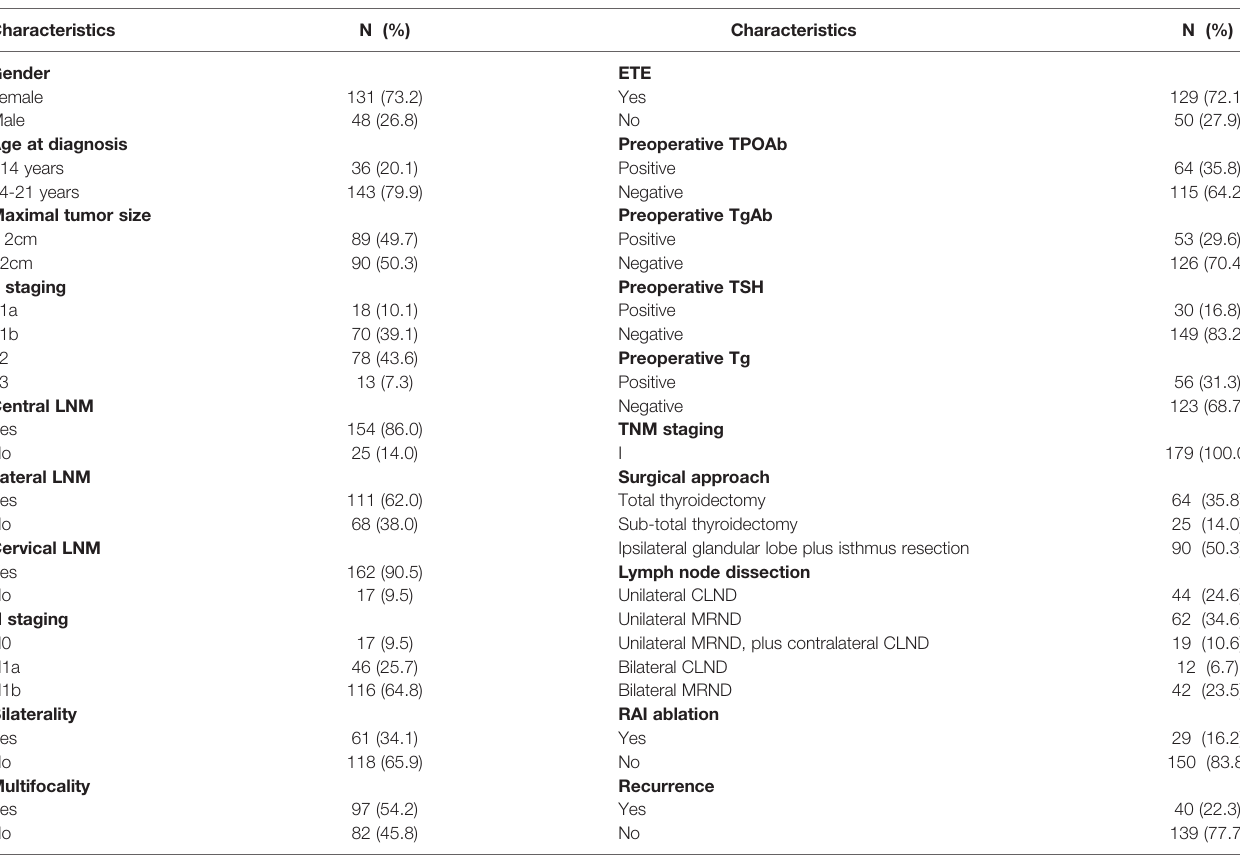
TABLE 1 | Characteristics of the study patients.